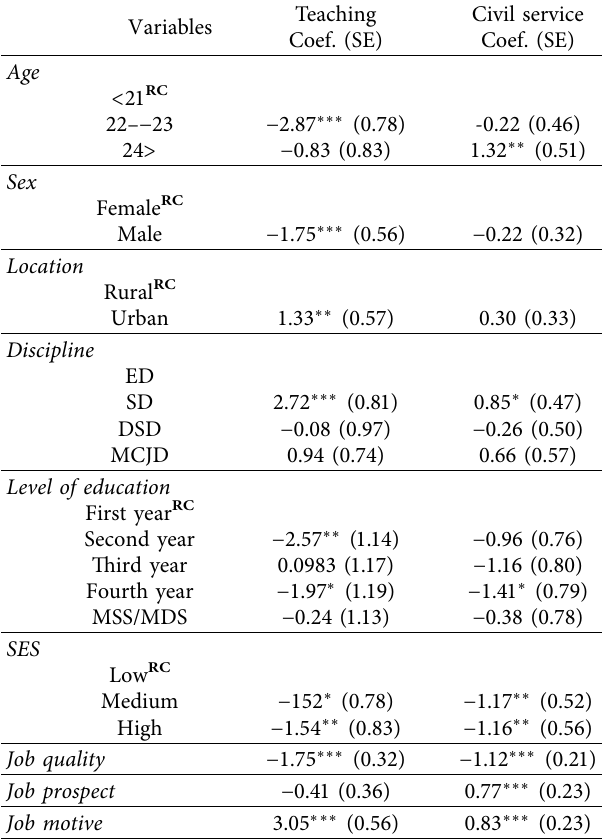
Table 4: Multinomial logistic regression showing the coefficient with a 9% confidence interval of teaching and other career choices of the graduates of Social Science